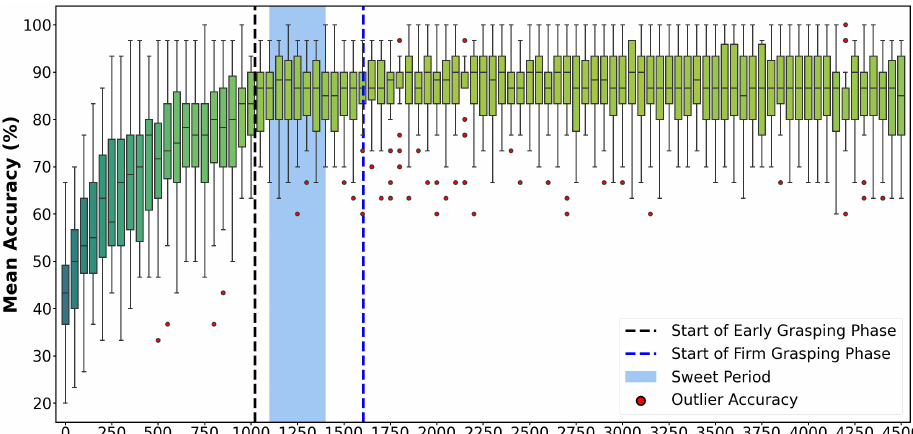
Figure 3. Mean accuracy at each time point during the entire grasp period. This result is from the model which was trained using all three phases data using leave-one-repetition-out cross-validation, and the mean accuracy represents the average accuracy of 30 subjects. The blue region, starts from 1100 ms and ends from 1400 ms, is the sweet period which was confirmed from the first experiment. The vertical dashed lines are averaged starting times of Early Grasping and Firm Grasping phases, which locates at 1020 ms and 1604 ms, respectively. The red dots are